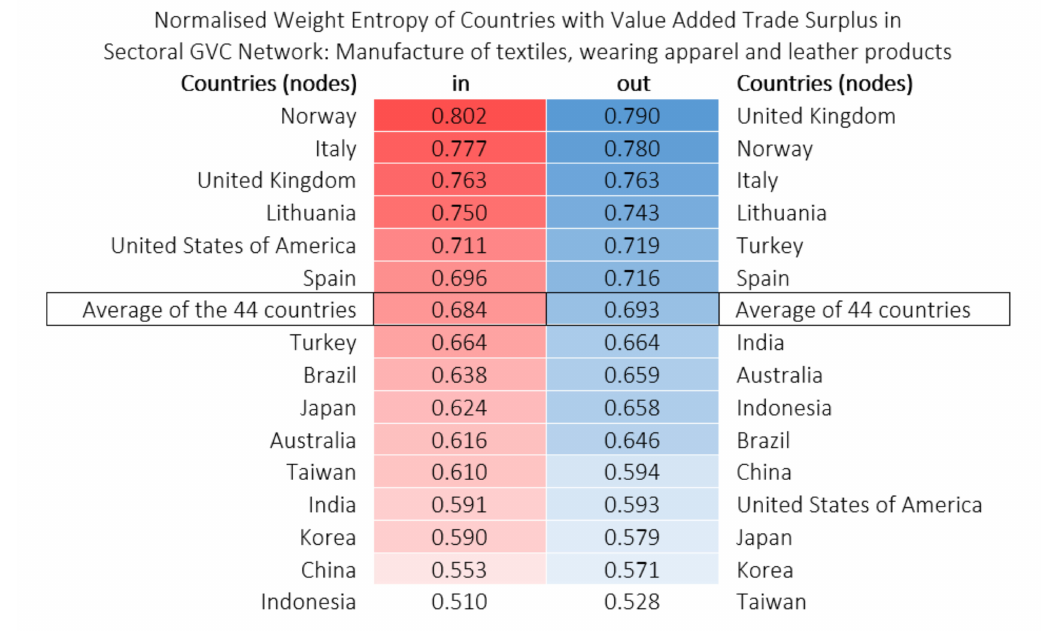
Figure 7. Sectoral GVC network: “Manufacture of textiles, wearing apparel, and leather products”. Normalized in- and out-weight entropy average (2000–2014) of countries with value added trade